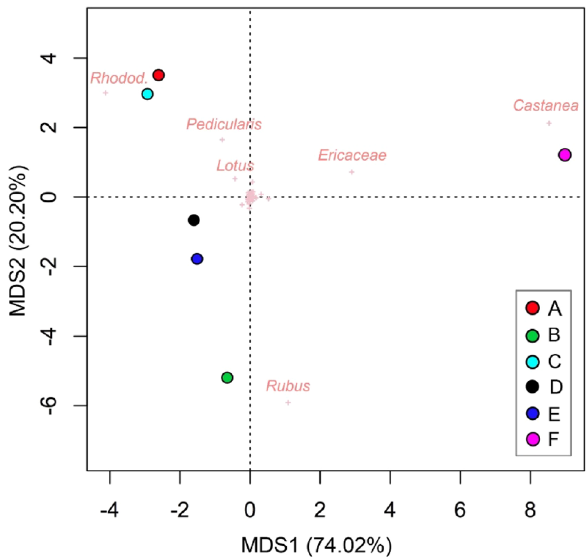
Figure 3. MDS of the melissopalynological analysis of the six samples (dots) of mountain wildflower honeys produced in the stations considered. The crosses are the pollens found in the honey samples, the most important are